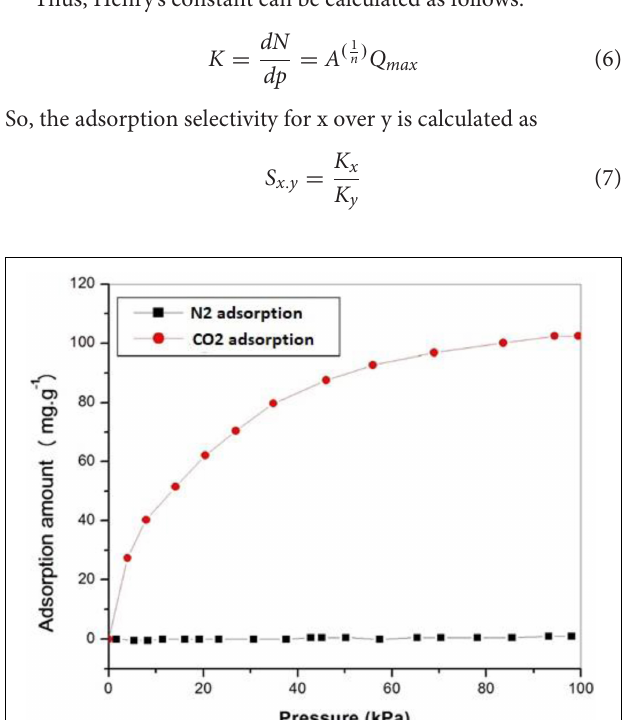
FIGURE 12 | CO 2 /N 2 selectivity of MMO-PEI-60 at 70 ◦ C.